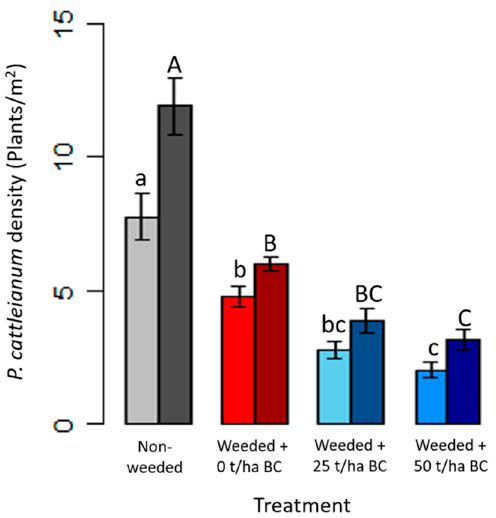
Figure 4. Density of strawberry guava individuals by treatment after 6 months (lighter colors) and 30 months (darker colors). Weeding (strawberry guava removal) and biochar treatments at rates of 0, 25, and 50 t/ha are compared to the non-weeded control. Means are plotted as ±1 SE; differences significant at p < 0.05 (Scheffe post hoc tests) are indicated by different letters (lowercase for 6-month period and uppercase for 30-month period).